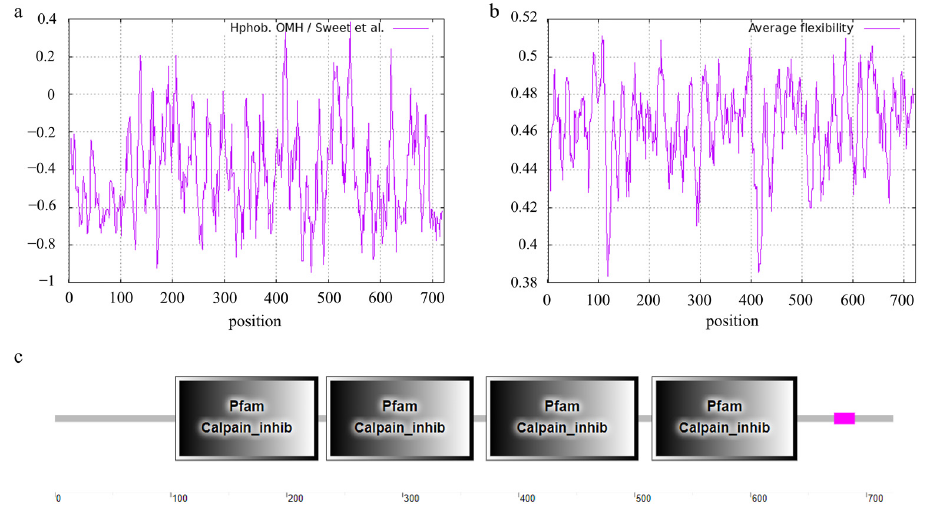
Figure 6. Feature and structure prediction of the ovine CAST protein. ( a ) CAST protein hydrophilicity was analyzed using ProtScale. ( b ) CAST protein average flexibility index was analyzed using ProtScale. ( c ) CAST protein conservative domains were predicted with SMART.